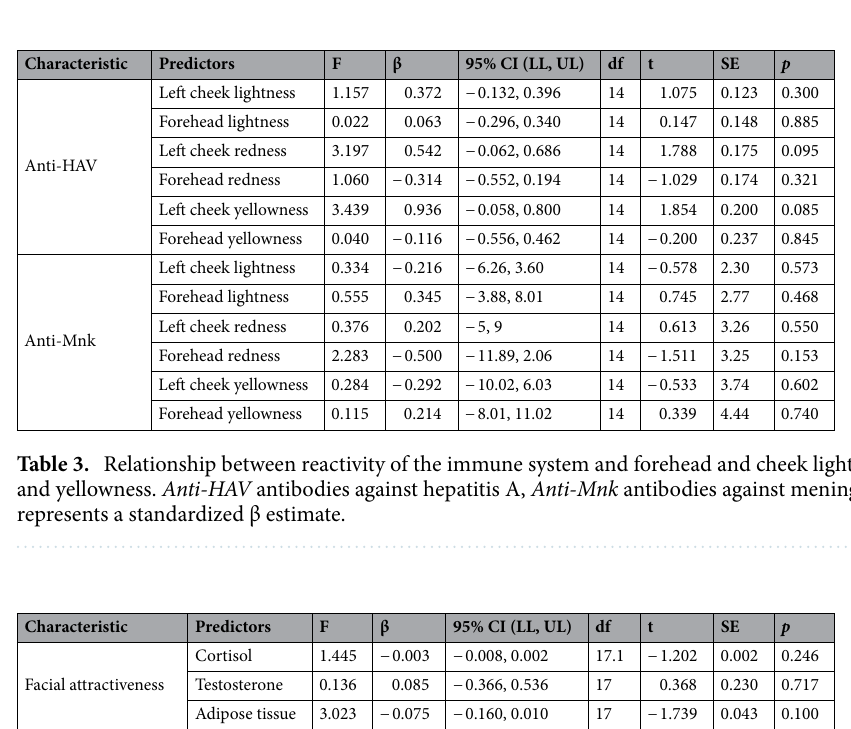
Table 2. Relationship between reactivity of the immune system and perceived facial characteristics. Attractiveness ratings: for target ID, VRC = 0.960, SD = 0.980, ICC = 0.429; for rater ID, VRC = 0.429, SD = 0.655, ICC = 0.251. Relationship between perceived healthiness and reactivity of the immune system. Facial healthiness ratings: for target ID, VRC = 0.876, SD = 0.936, ICC = 0.374; for rater ID, VRC = 0.458, SD = 0.677, ICC = 0.238. Relationship between perceived cheek patch healthiness and reactivity of the immune system. Cheek patch healthiness ratings: for target ID, VRC = 0.608, SD = 0.780, ICC = 0.324; for rater ID, VRC = 0.487, SD = 0.698, ICC = 0.278. Anti-HAV antibodies against hepatitis A, Anti-Mnk antibodies against meningococcus, VRC variance of random components.